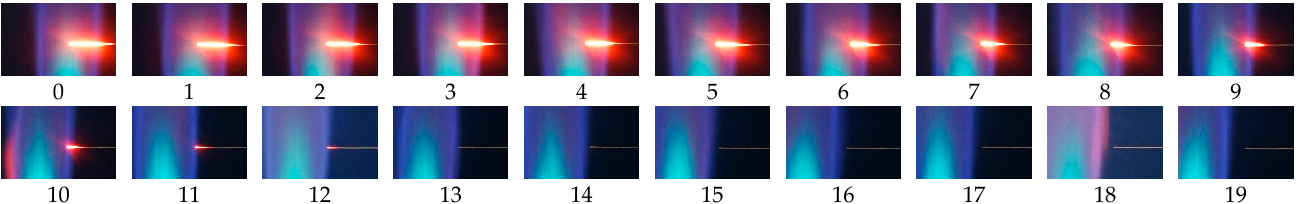
Figure 12. Flame photos at ∆ 2a = 0–17 mm under ∆ 1a = 50 mm. The numbers below each image represent the values of ∆ 2a .